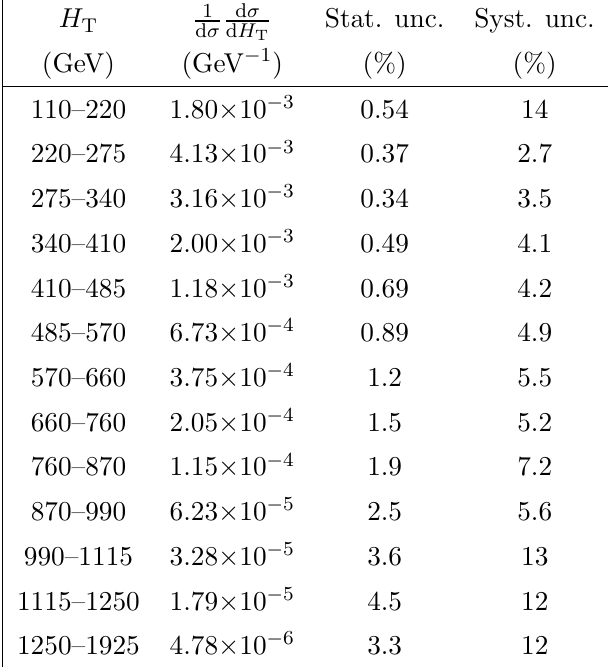
Table 5 . Results of the normalised di(cid:11)erential cross sections with relative uncertainties in the combined channel with respect to H T .